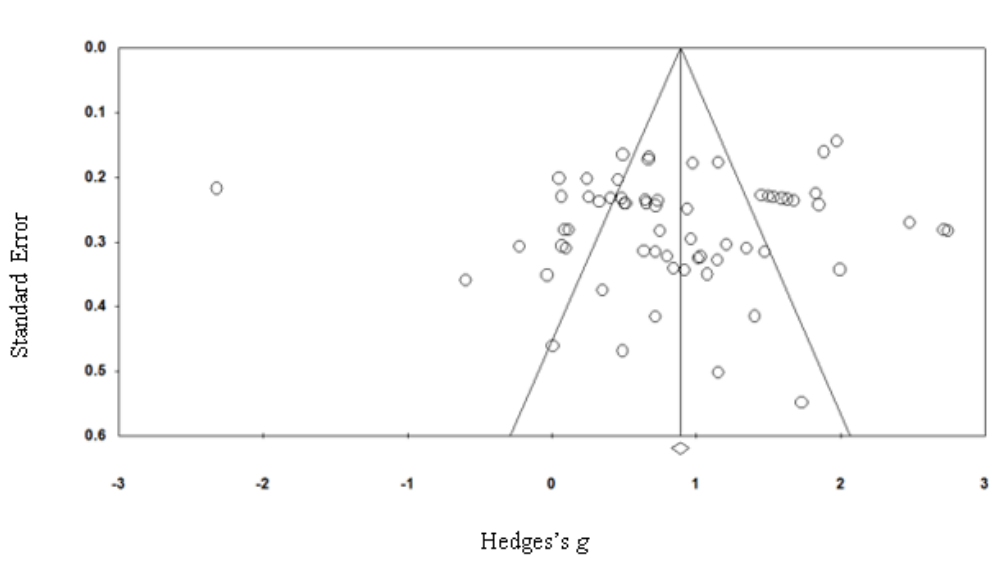
Figure 2. Funnel plot for the effects of scaffolding on learning